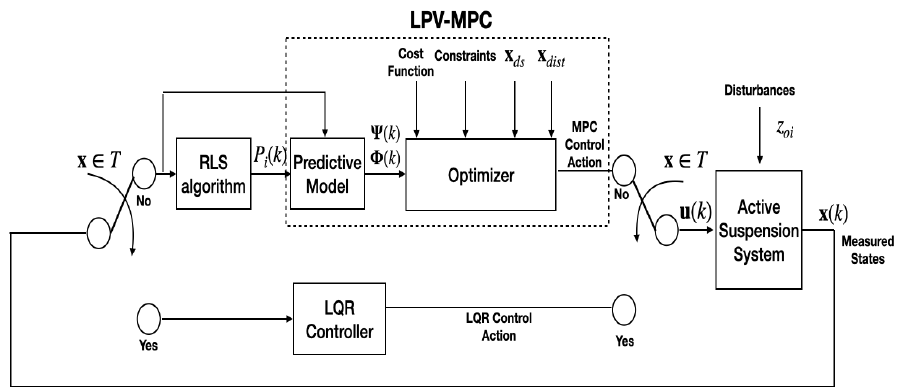
Figure 3. Block diagram of the proposed LPV-MPC-LQR control strategy for the Half-Car Active Suspen- sion